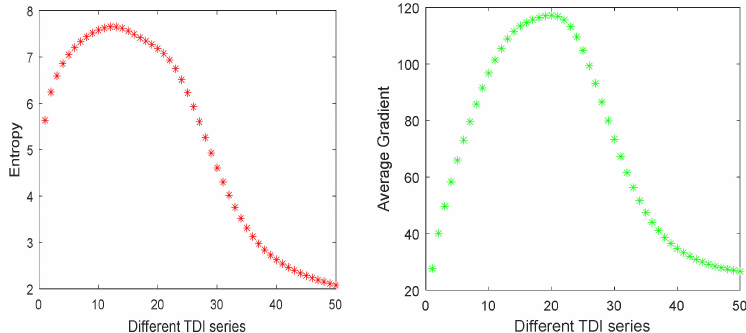
Figure 2. The correlation between information entropy and mean gradient with TDI series.